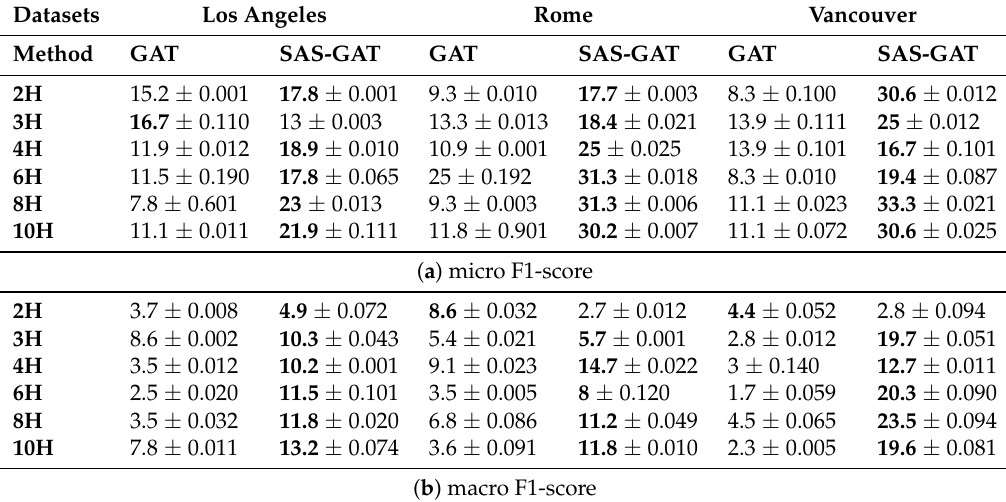
Table 4. Summary of results for our method. We compare with GAT using the micro and macro F1-score (%). Results in sub-table ( a ) are achieved training using a balanced set of training nodes. Sub-table ( b ) denotes results achieved using a set of training nodes proportionate to the class size. Best results for each case are in bold.